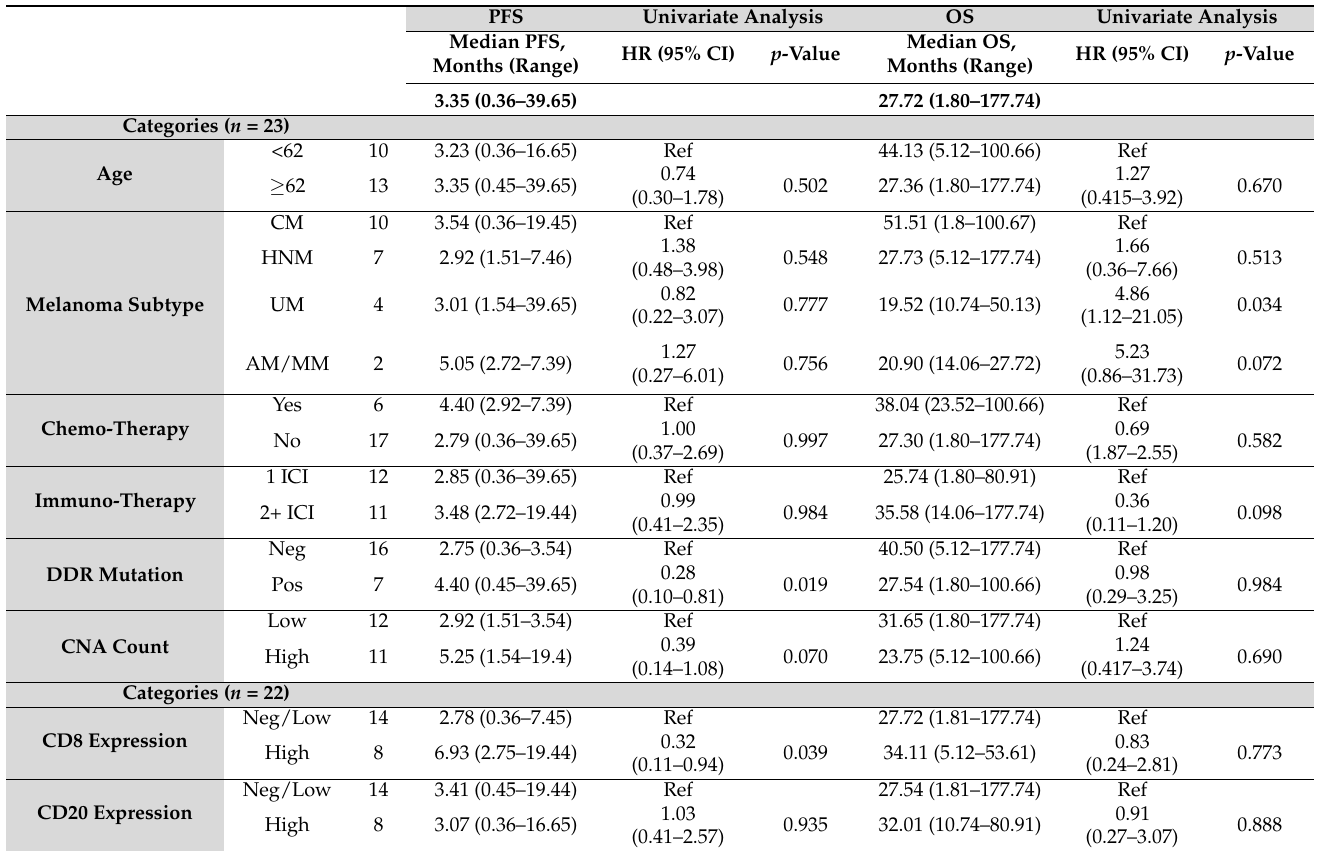
Table 2. Univariate Cox Regression analysis of clinical variables associated with PFS and OS. PFS Univariate